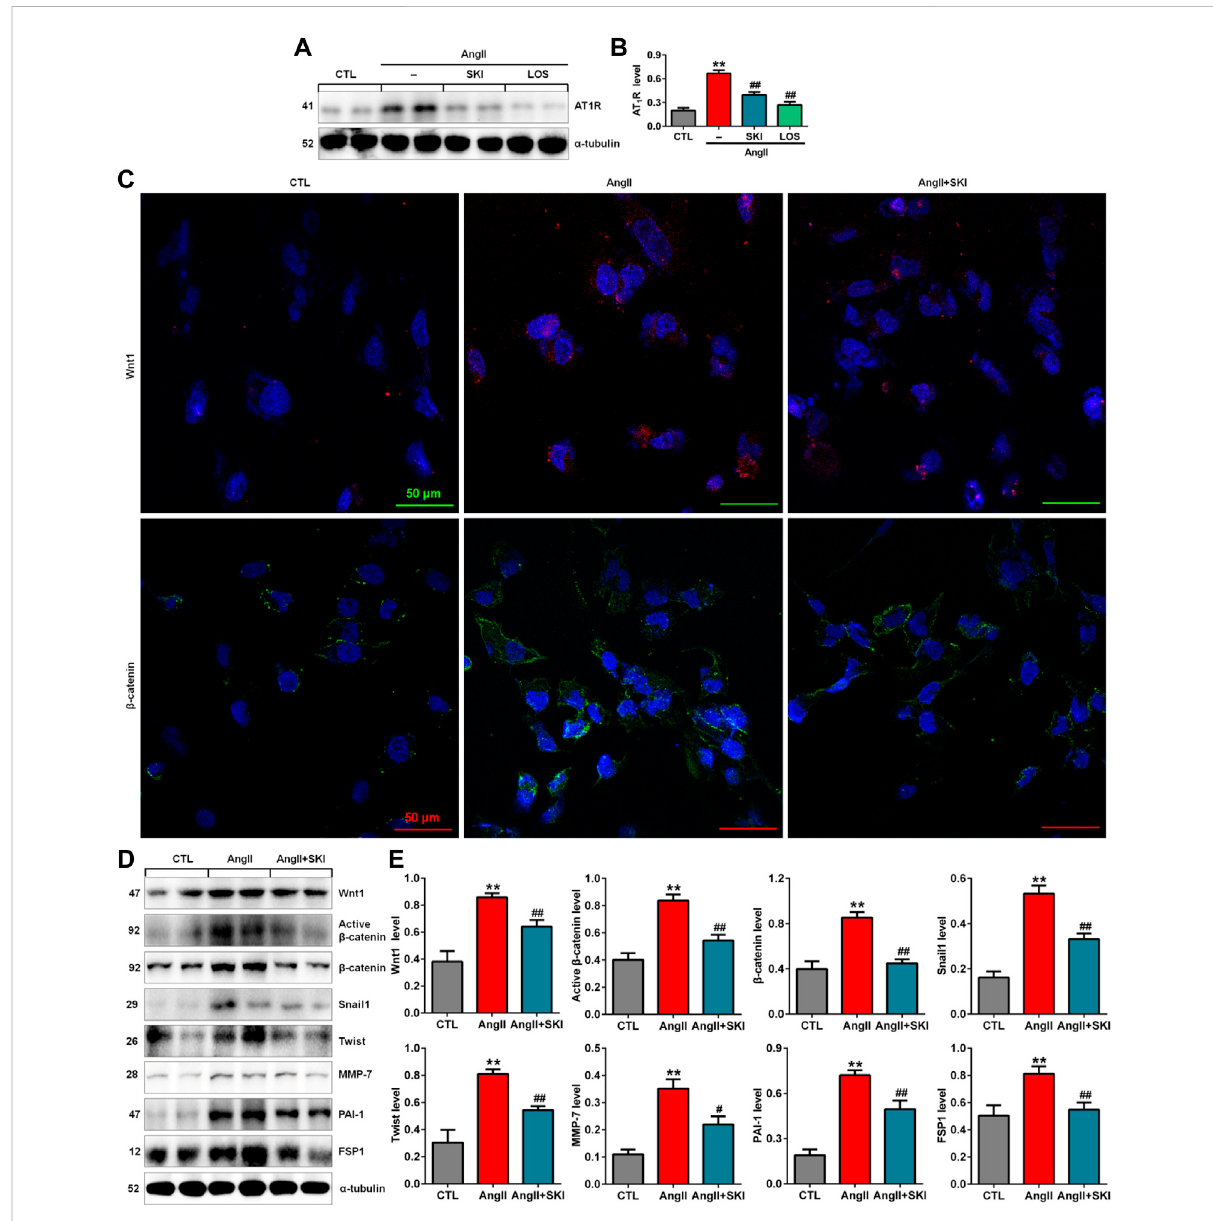
FIGURE 5 SKI inhibited the RAS/Wnt/ β -catenin signalling axis in AngII-induced HK-2 cells. (A) Protein expression of AT 1 R in AngII-induced HK-2 cells treatedwithSKIandlosartan. (B) QuantitativeanalysisoftheproteinexpressionofAT 1 RinAngII-inducedHK-2cellstreatedwithSKIandlosartan. (C) Representative immuno fl uorescent analysis of Wnt1 and β -catenin in AngII-induced HK-2 cells treated with SKI. (D) Protein expression of Wnt1, active β -catenin and β -catenin, as well as its downstream target gene products, including Snail1, Twist, MMP-7, PAI-1, and FSP1, in AngII- induced HK-2 cells treated with SKI. (E) Quantitative analysis of Wnt/ β -catenin signalling pathway protein expression in AngII-induced HK-2 cells treated with SKI. ** p < 0.01 compared with the control group; # p < 0.05, ## p < 0.01 compared with the AngII-induced